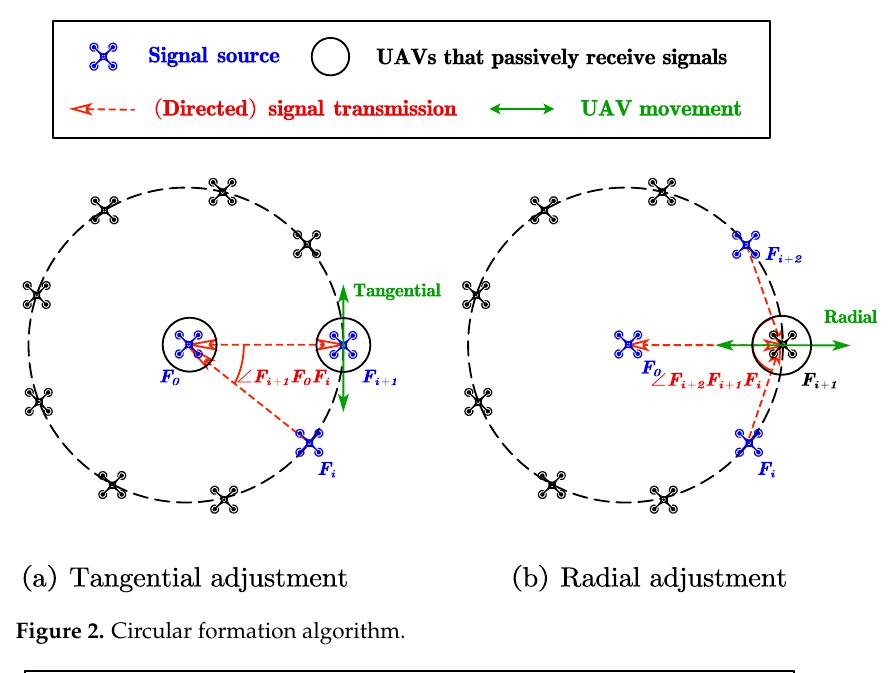
Figure 2. Circular formation algorithm.